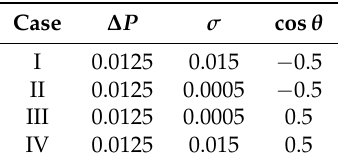
Table 1. Parameters used in four typical cases of immiscible